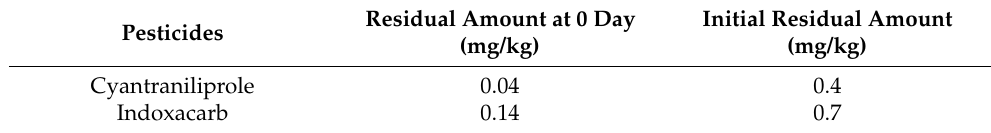
Table 2. Cyantraniliprole and indoxacarb initial residues in wild garlic. Residual Amount at 0 Pesticides